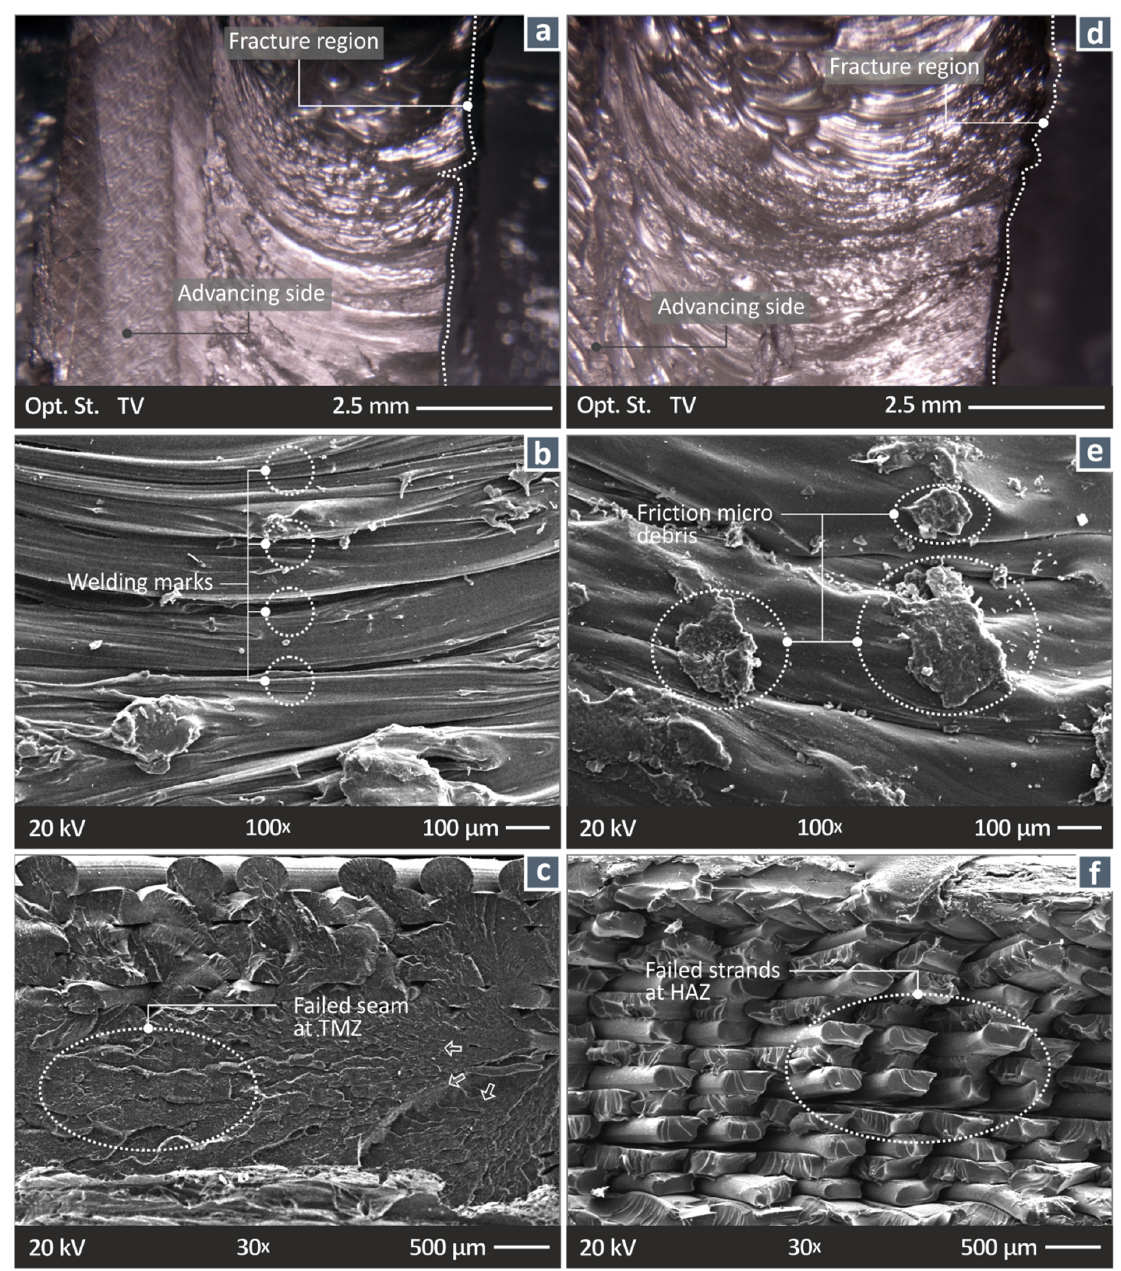
Figure 6. Morphological evaluation (( a – c ): specimen welded at 1000 rpm, 6 mm/min, PPA; ( d – f ): specimen welded at 1000 rpm, 9 mm/min, PPB). Stereoscopic images: ( a ) weld zone (PPA); ( d ) weld zone (PPB). SEM images: ( b ) fracture surface at 100× (PPA); ( c ) fracture surface at 30× (PPA) (arrows in the image indicate how the fracture evolved in the surface); ( e ) fracture surface at 100 × (PPB); ( f ) fracture surface at 30 × (PPB) (TMZ: thermomechanical zone, HAZ: heat-affected